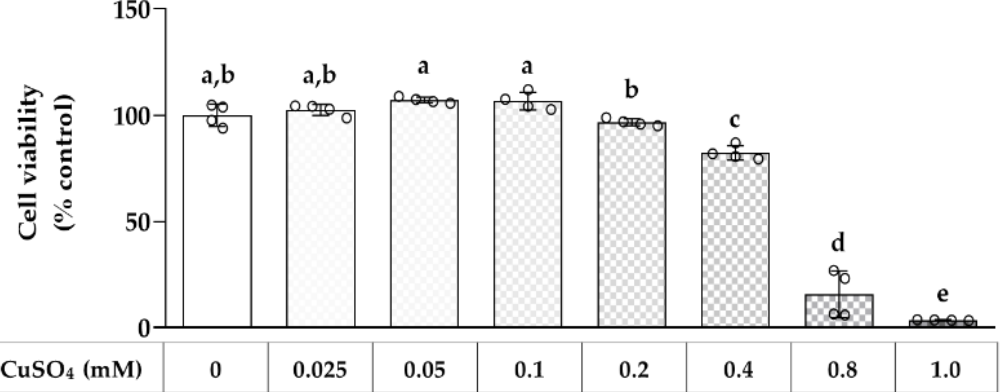
Figure 2. Effects of CuSO 4 on the viability of HaCaT cells. Cells were treated with CuSO 4 at varying concentrations for 48 h for the viability assay. Cell viability is presented as % of the control group (mean ± SD, n = 4). Different lowercase letters (a–e) indicate significantly different means at the p < 0.05 level.